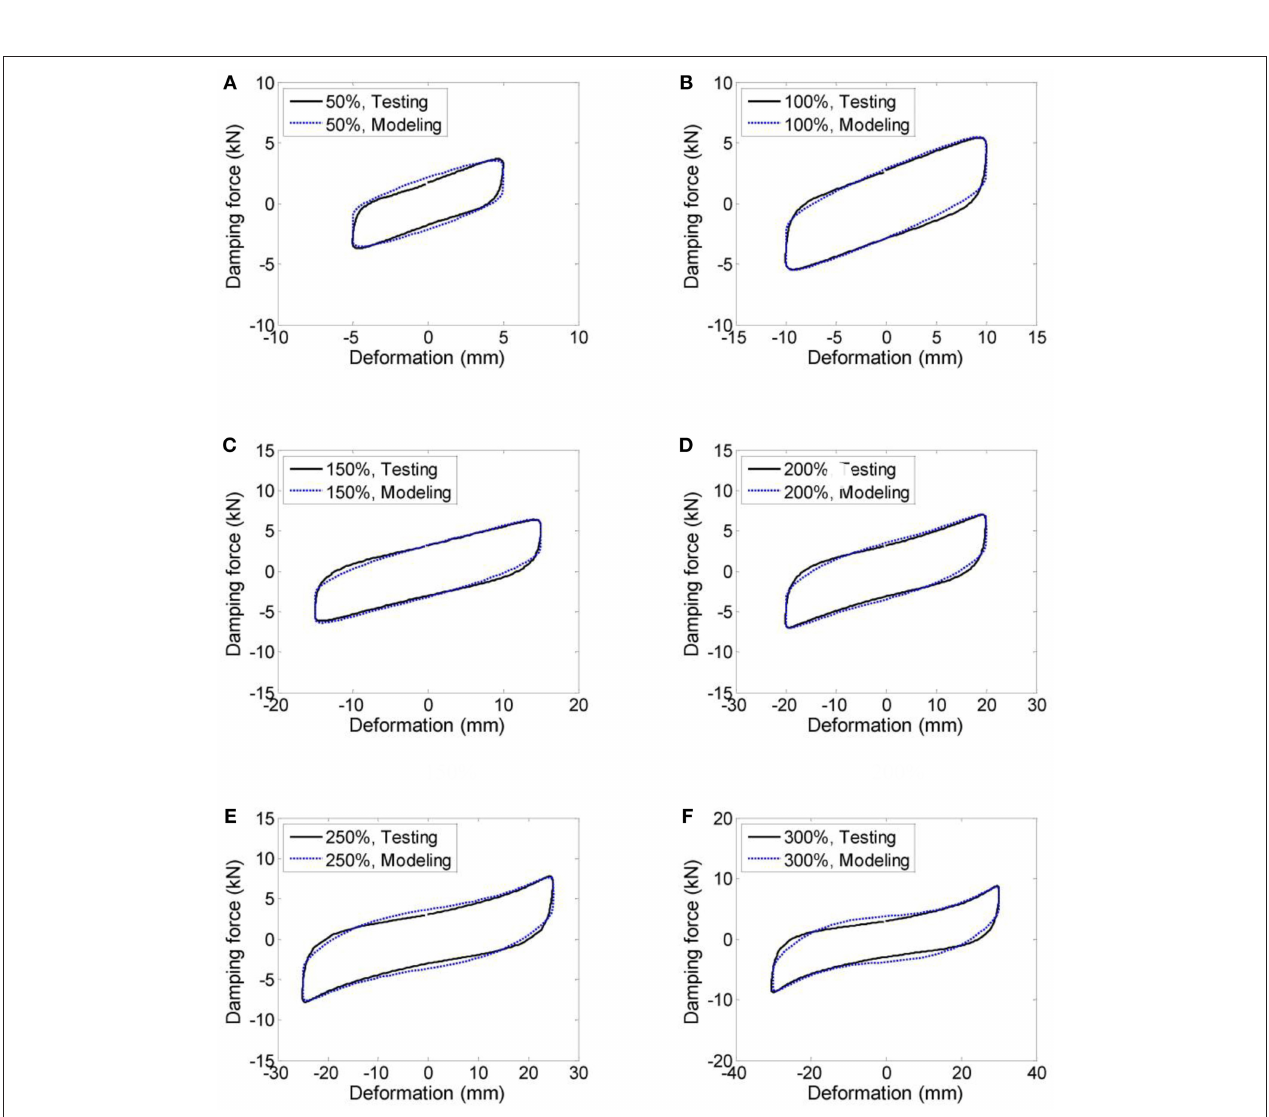
FIGURE 8 | Comparison between the mechanic model and the performance test hysteresis loop (VE60 × 60 × 10) under strain deformation of (A) 50%, (B) 100%, (C) 150%, (D) 200%, (E) 250%, and (F) 300%.